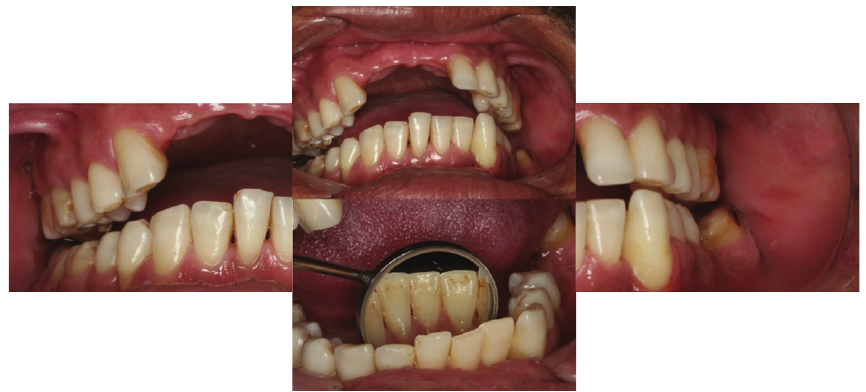
Figure 3: Clinical features after periodontal therapy. Good hygiene without calculus or plaque.